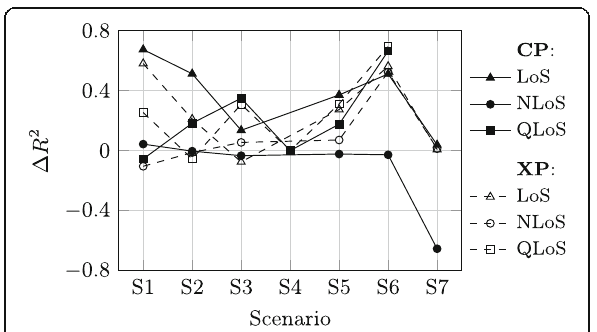
Fig. 6 Relative R 2 values compared to the typical approach